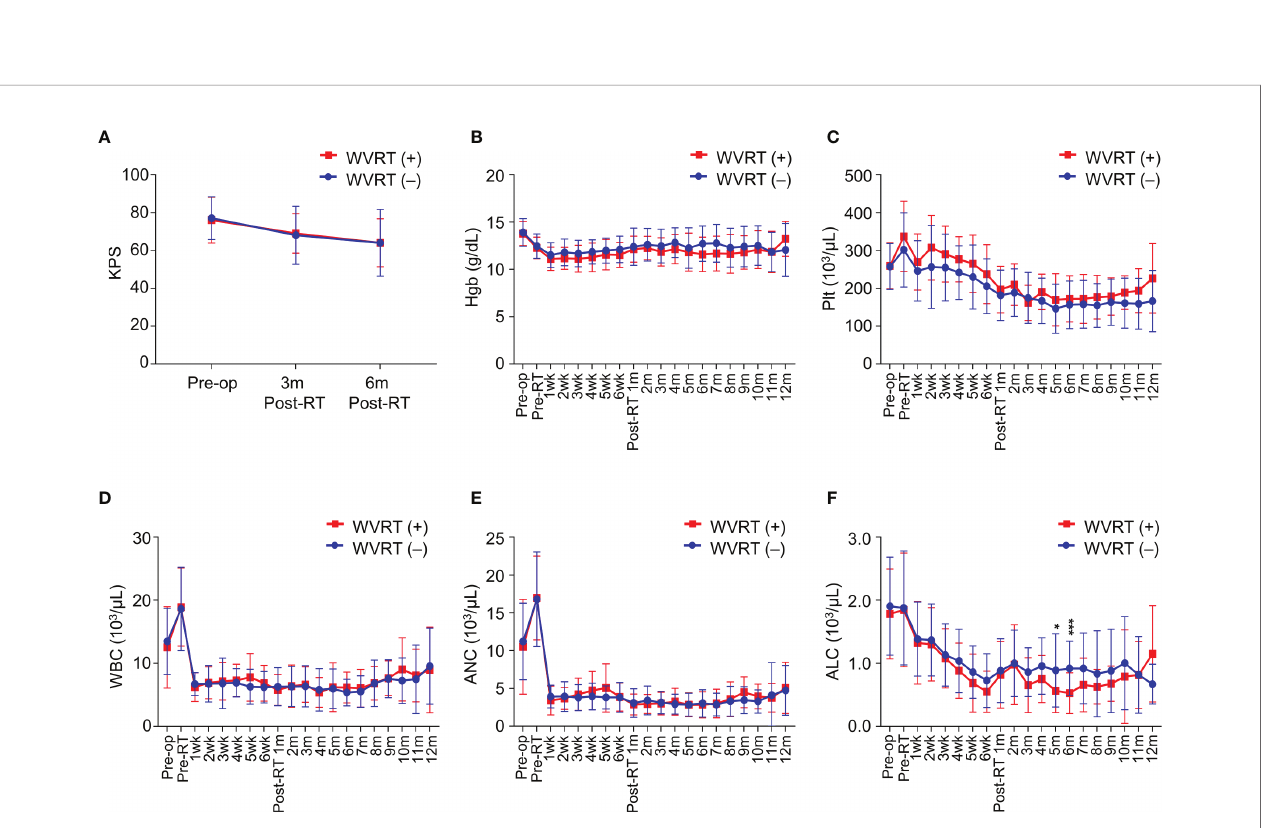
FIGURE 5 | Performance status and blood cell counts during and after treatment in the propensity score-matched cohort (n=170). (A) Karnofsky performance score (KPS) before surgery, 3 months post-radiotherapy, and 6 months post-radiotherapy. (B – F) Serial values of blood test fi ndings from before surgery to 12 months post-radiotherapy in terms of hemoglobin level (B) , platelet count (C) , white blood cell count (D) , absolute neutrophil count (E) , and absolute lymphocyte count (F) . ***P<0.001;